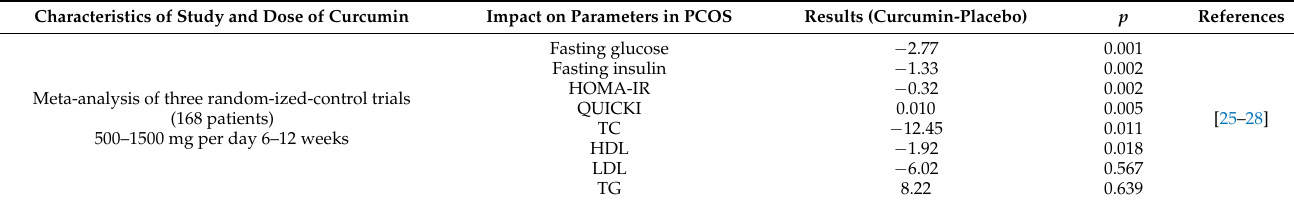
Table 1. The results of curcumin supplementation in